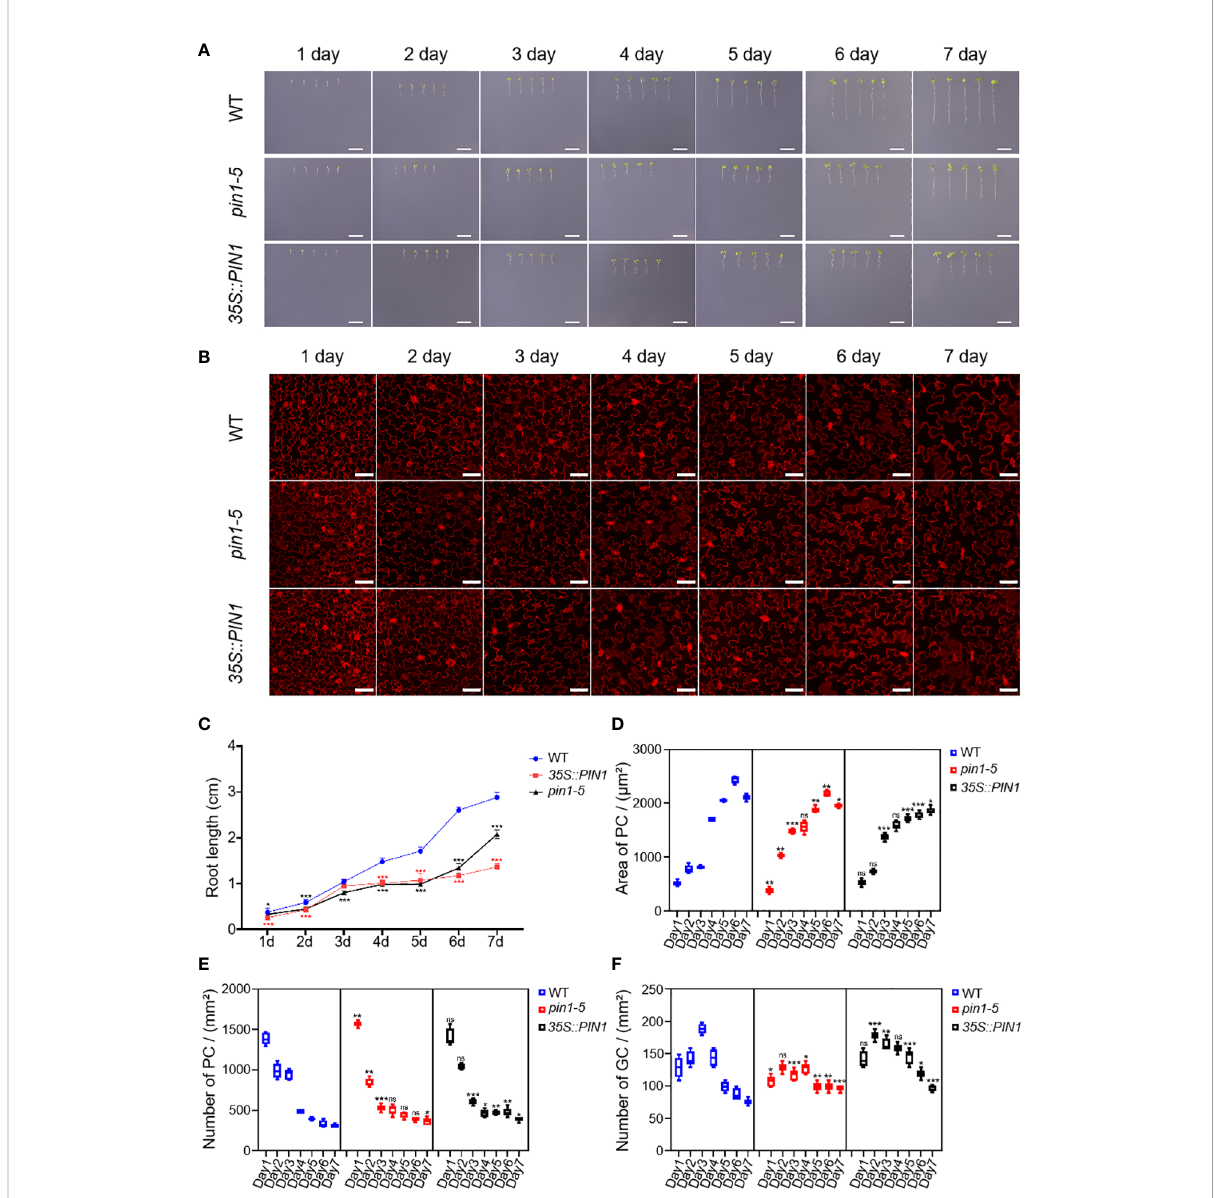
FIGURE 5 Analysis of PC and GC development in pin1-5 , 35S::PIN1 and WT under NaClconditions. Analysisof the growth of pin1-5 , 35S::PIN1 and WT under control conditions. (A) The seeding of pin1-5 , 35S::PIN1 and WT weregrown in1/2 MSplates plus100 mMNaClfor 7 days. The seedlingsgrown for 1~7 days werephotographed continuouslyby a cameratorecordtheir developmental and growth phenotypes, anduntreated seedlings wereused as controls. Scalebar:1 cm. (B) The development ofPC and GCwas measured under the following conditions: pin1-5 , 35S::PIN1 and WT seedlings were grown in 1/2 MS plates plus 100 mMNaCl for 1~7 days, thenharvested and stained with PI for 30 min tostain the membrane. After PI staining, PC and GC ′ s weredetected under a confocal laser microscope. Scale bar:50 m m. (C) Statistical analysis ofthe rootlength ofseedlingsof pin1-5 , 35S::PIN1 and WT (n= 5). (D) Statistical analysis of the sizeof PCsin the lower epidermis ofcotyledons of seedlings of pin1-5 , 35S::PIN1 and WT(n= 5). (E) Statistical analysis of the intensity of PCsin the lower epidermis of cotyledons of seedlingsof pin1-5 , 35S::PIN1 and WT (n= 5). (F) Statistical analysis ofthe intensity ofGCs inthe lower epidermisof cotyledons of seedlings of pin1-5 , 35S::PIN1 and WT (n= 5).The data wereanalyzed by one-way ANOVA following Brown – Forsythe test. ns: p > 0.05; *p< 0.05; **p < 0.01; ***p<